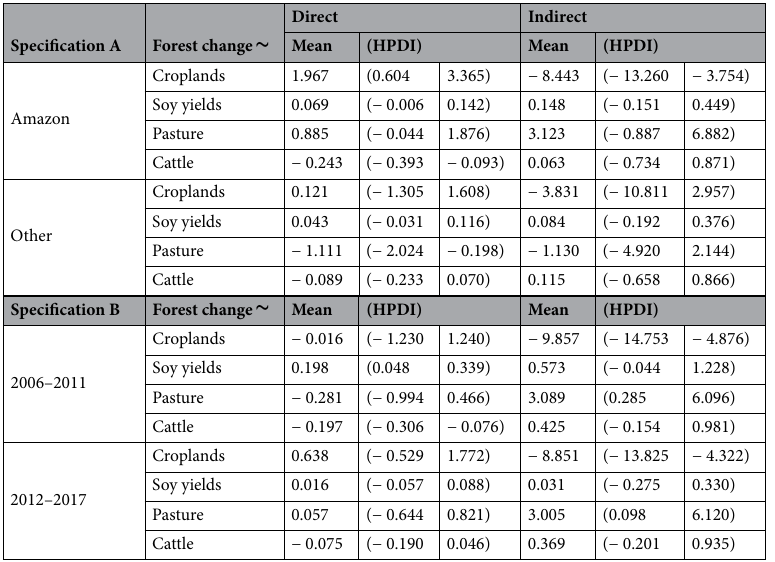
Table 2. Regressions with heterogeneous effects across biomes and over time periods. Specification A on the top allows effects for the Amazon biome to differ from the rest of the state. Specification B on the bottom allows different effects for the 2006–2011 and 2012–2017 periods. See Table 1 for further